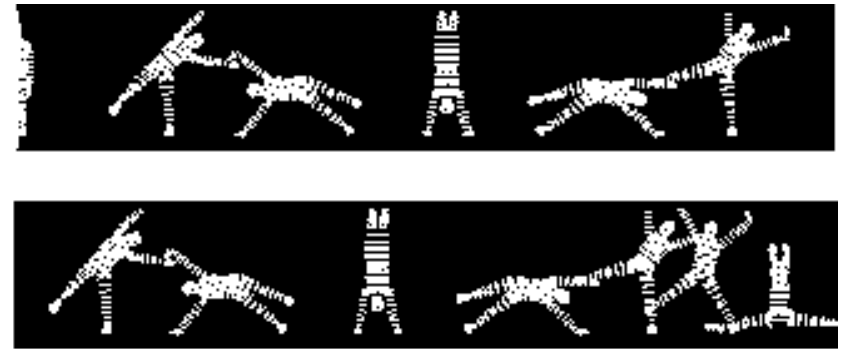
Figure 4.10. Existing Sequence selected by Chance